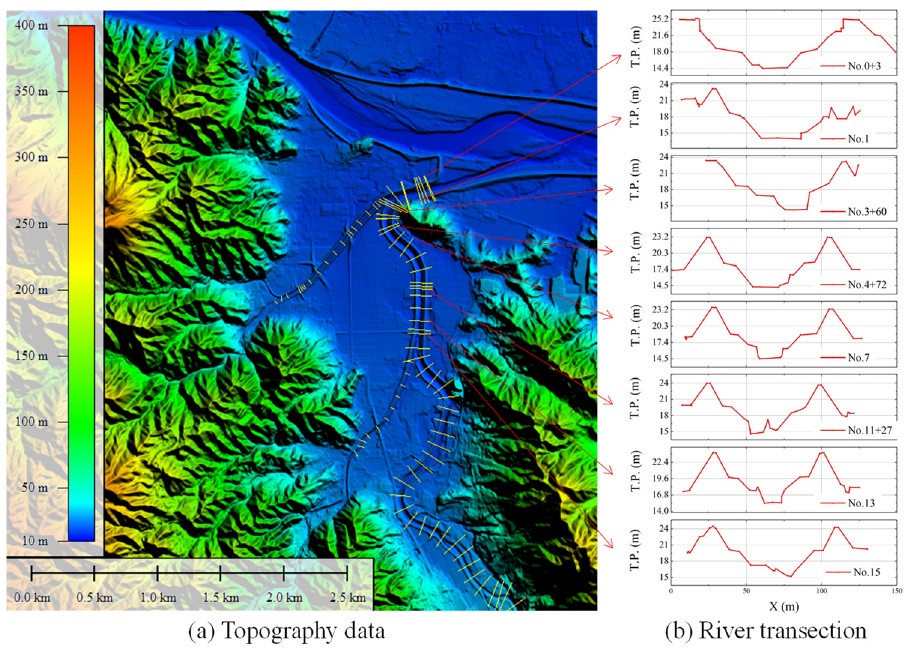
Figure 3. ( a ) 5 m-topography data of the Marumori area, ( b ) measured transects of tributaries.